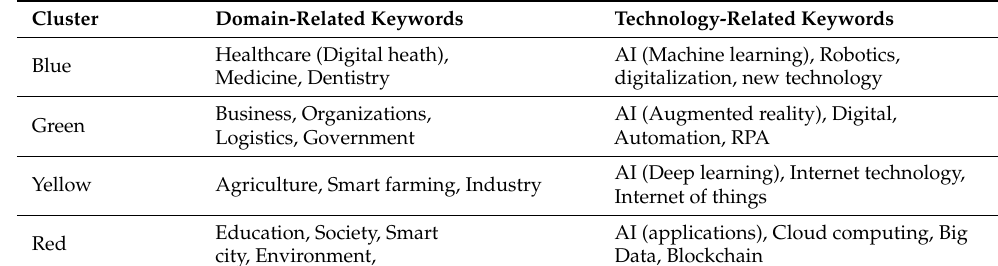
Table 2. Cluster identification and domain- and technology-related keywords.